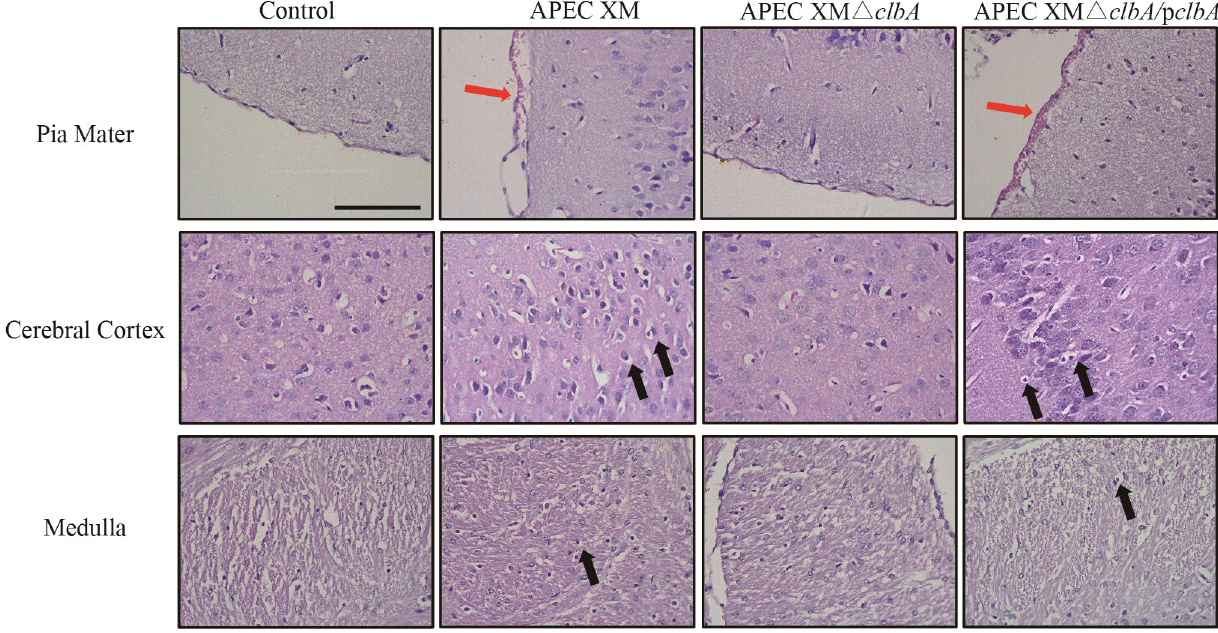
Fig 8. Histopathological analysis of the brain tissue of 4-week-old ICR mice infected with APEC XM, APEC XM Δ clbA and APEC XM Δ clbA /p clbA and non-infected mice. Sections were stained with hematoxylin-eosin and visualized with an optical microscope (bar = 100 μ m). Thickened pia mater with hemorrhage (red arrowheads) was observed in the brain section of mice infected by APEC XM and APEC XM Δ clbA /p clbA .Leukocyte infiltration (black arrowheads) was observed in the cerebral cortex and medulla of mice infected with APEC XM and APEC XM Δ clbA /p clbA .